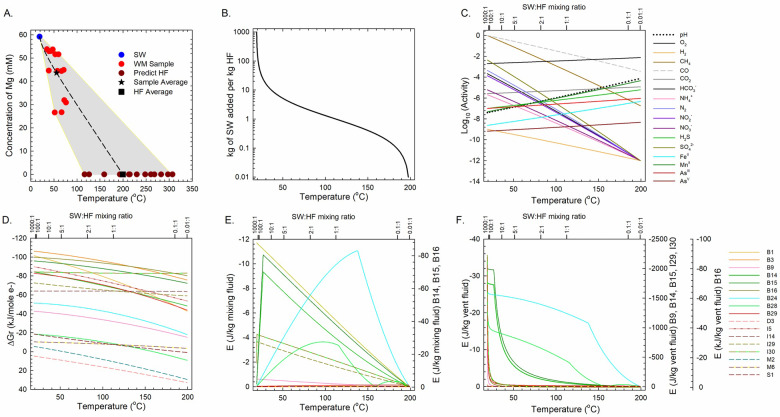
Temperature, composition and energetics resulting from the hydrothermal fluid-seawater mixing model.(A) Extrapolated temperature of end-member HF at [Mg] = 0 (brown circles) based on values of [Mg] in WM samples (red circles) and SW (blue circle). The temperature, composition and energetics of redox reactions resulting from fluid mixing were calculated using the average WM composition (black star) and average HF composition (black square). (B) Fluid temperature as a function of SW:HF mixing ratio. (C) Activities of redox-sensitive species as a function of temperature and SW:HF mixing ratio. Values of ΔGr (D) and Efluid (E, F) of exergonic reactions listed in Table 4. Because the results span several orders of magnitude, reactions B14, B15 and B16 have a different Y-axis scale on right side in (E); and reactions B9, B14, B15, I29, I30, and B16 refer to the two Y-axis scales on the right side in (F).